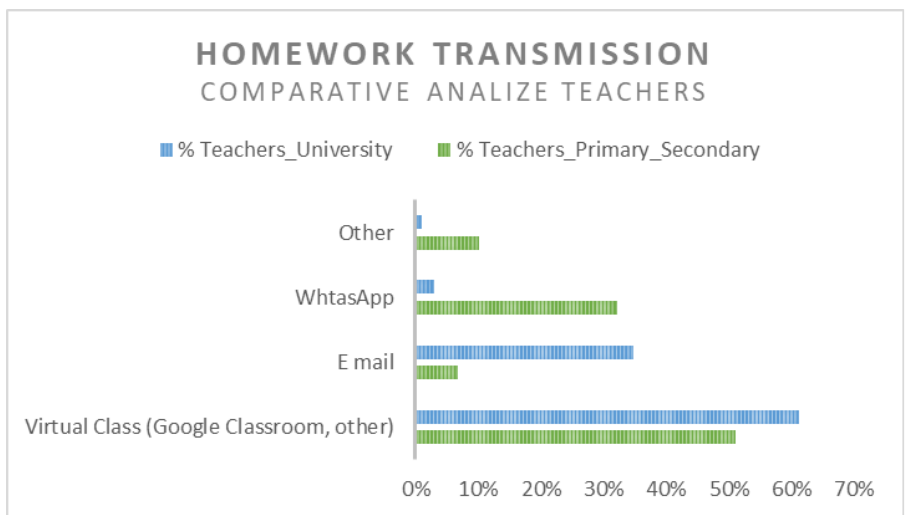
Figure 5. Different perception for homework transmission method used by academic teachers and primary and secondary teachers.